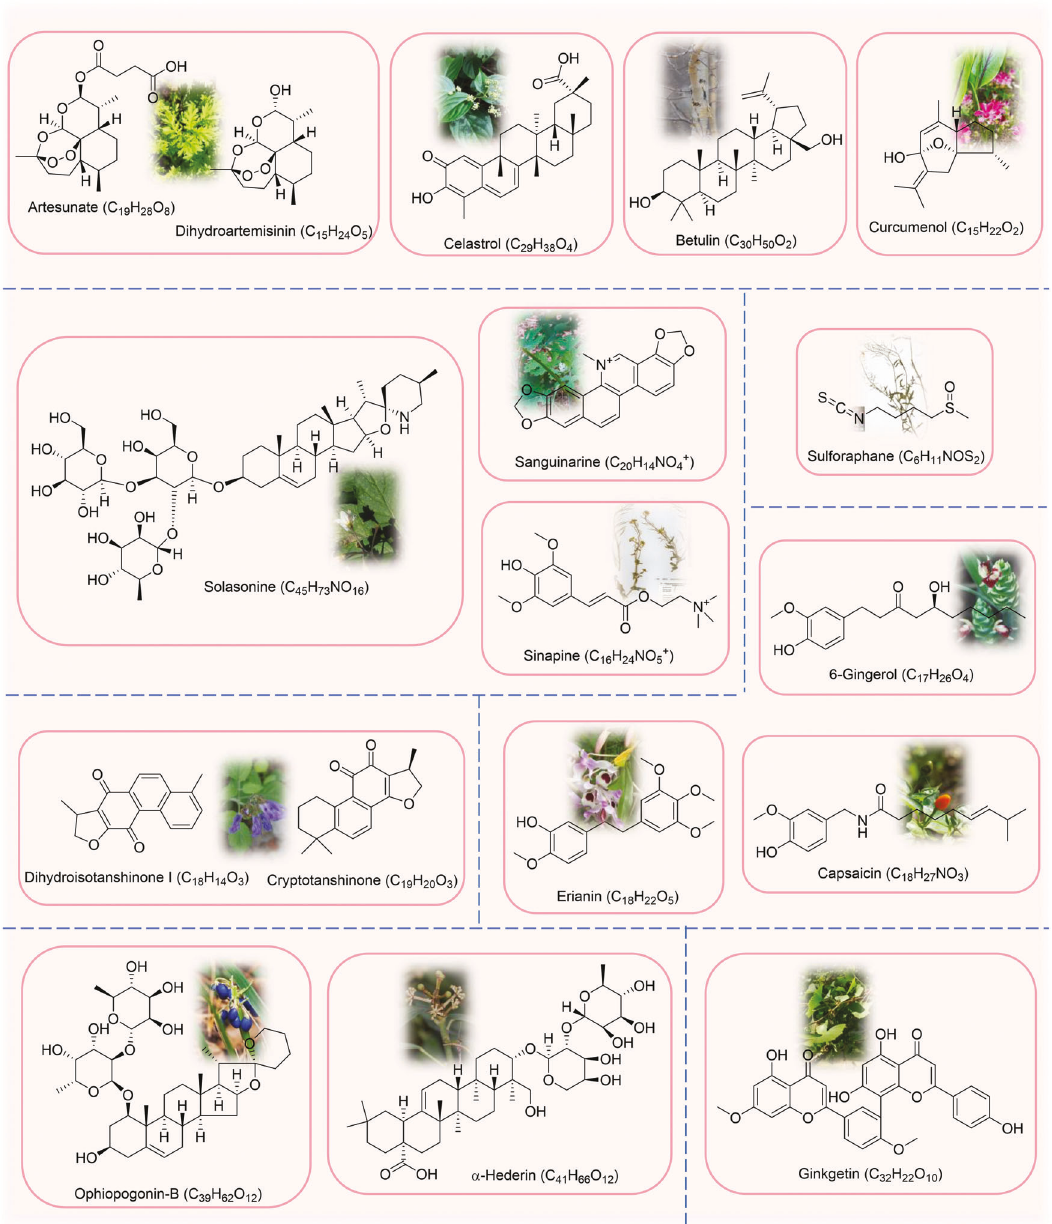
fl avonoids. Figure 5 lists the sources and chemical formulas of natural products currently acting on ferroptosis for lung cancer treatment, and their regulatory targets and mechanisms are shown in Fig. 6 and Table